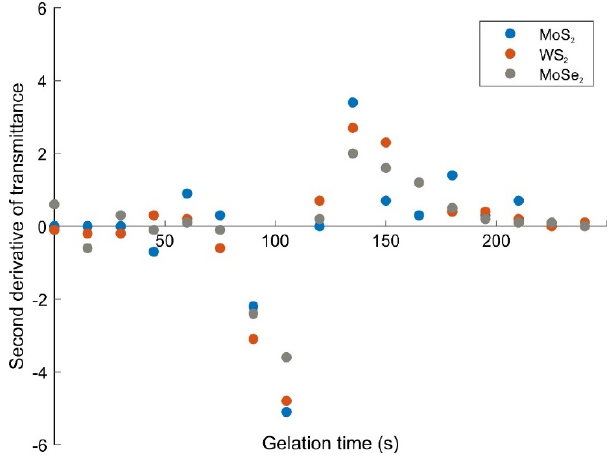
Figure 3. Second derivative of transmittance of the TMD-doped PAAm gels with respect to time. All composite gels were allowed to dry at room temperature. The relationship between the amount of TMDs and the transmittance response of the composite gels to the incident photon is shown in Figure 4. A decrease in transmittance due to WS 2 content occurs. The change in the color of the gel and its gradual darkening from clear to black are shown in Figure 1c. This observation is in agreement with the change in transmittance in Figure 4. Both MoS 2 and MoSe 2 -enhanced PAAm composite gels have also the same trend- line. Transmittance of MoSe 2 –PAAm composites with various MoSe 2 amounts measured using a uv-vis spectrophotometer is inversely proportional to the MoSe 2 amount as ex- pected. For MoS 2 -enhanced PAAm composite gels, when the light transmission behavior is examined, a decrease in the form of exponential decay of transmittance is observed as the amount of MoS 2 increases. If these gels are to be used for a multifunctional application, it will not be sufficient to have only transparent, only conductive, or only elastic property.